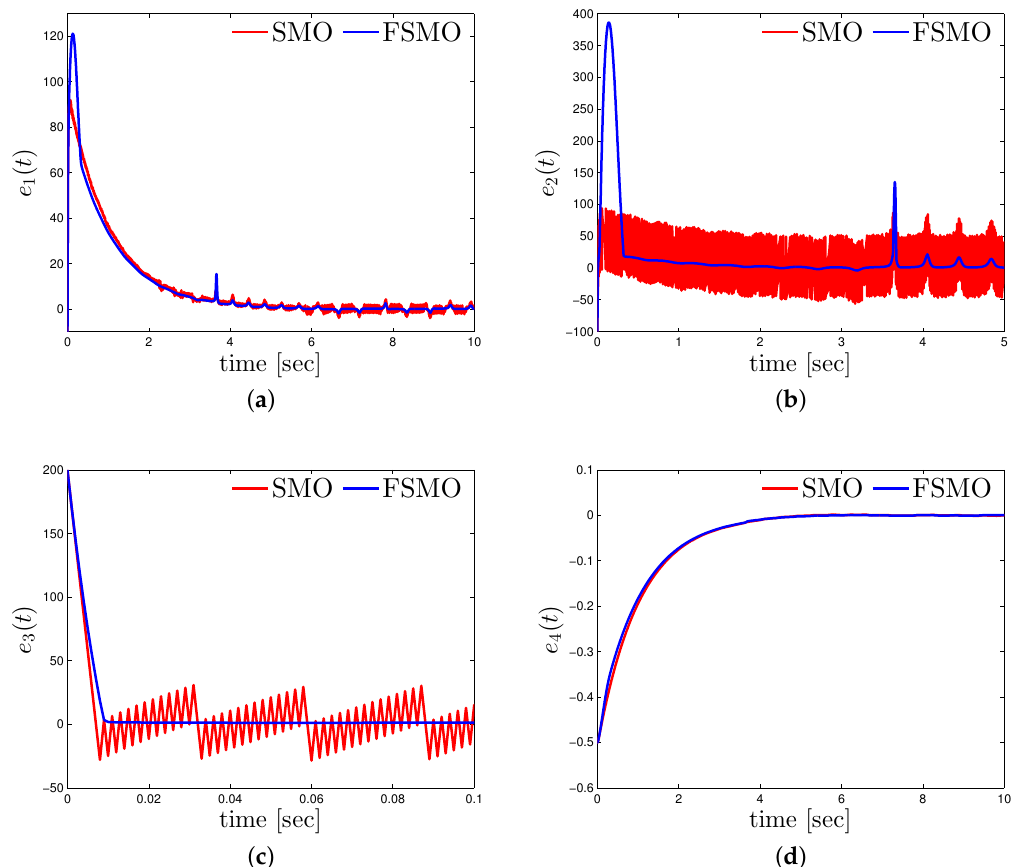
Figure 5. Time evolution of synchronization: ( a ) Error signals e 1 ( t ) . ( b ) Error signals e 2 ( t ) . ( c ) Error signals e 3 ( t ) . ( d ) Error signals e 4 ( t )